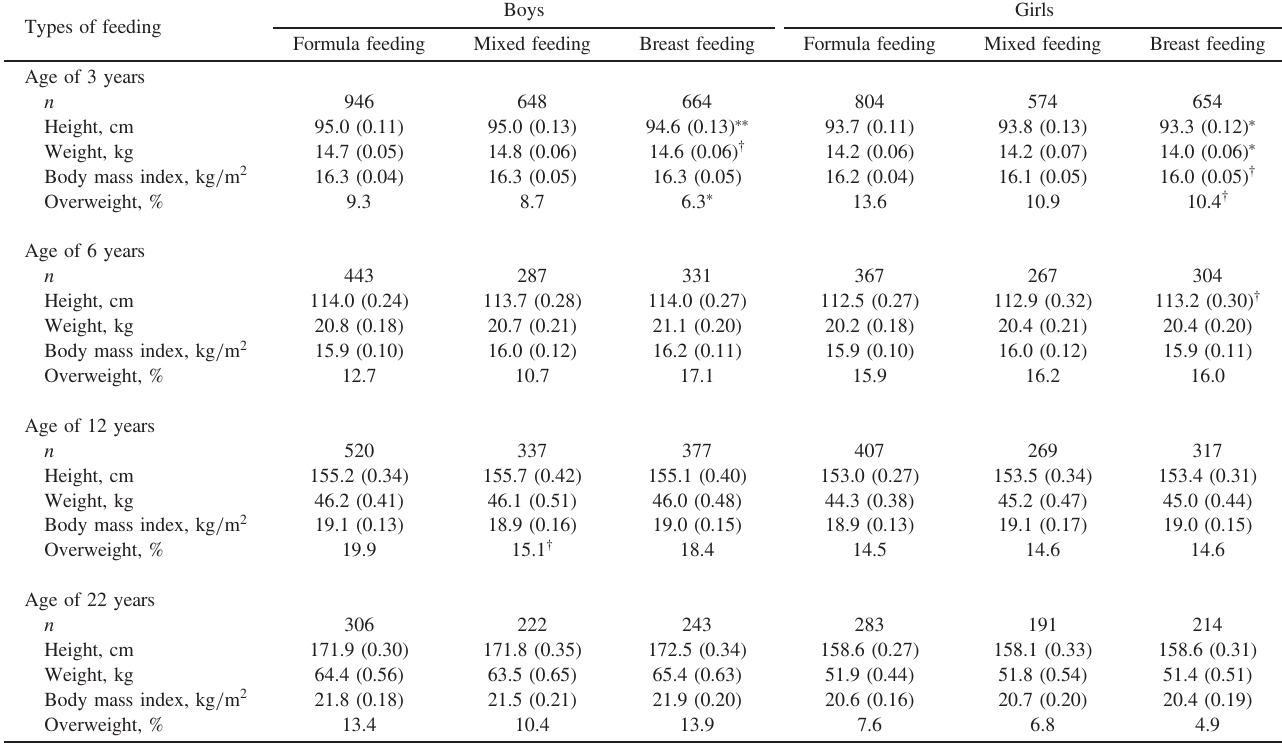
Table 2. Multivariable-adjusted mean values (standard errors) and proportions of physical size according to the types of feeding at ages of 3, 6, 12, and 22 years Boys Girls Types of feeding Formula feeding Mixed feeding Breast feeding Formula feeding Mixed feeding Breast